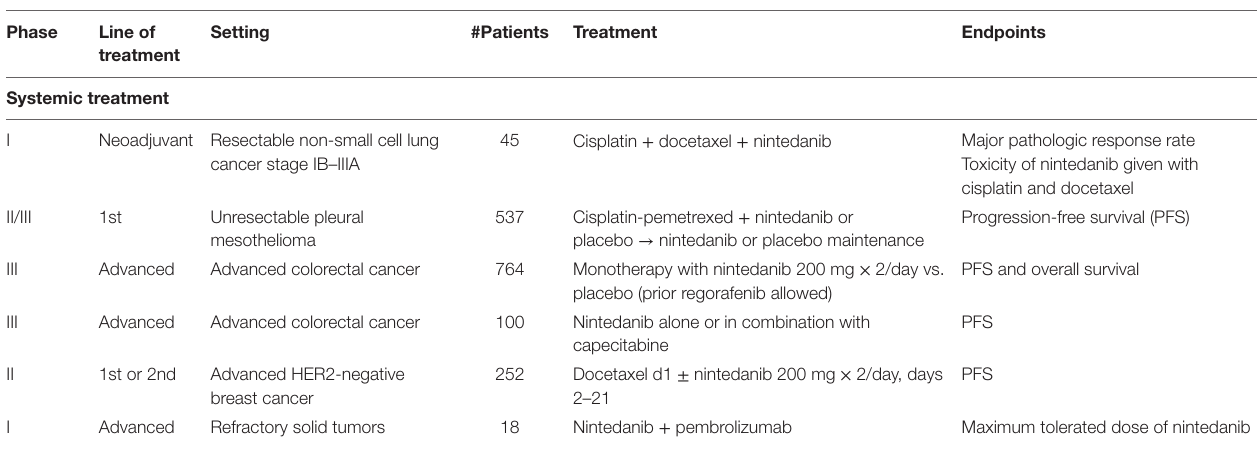
TABLe 3 | Ongoing studies with